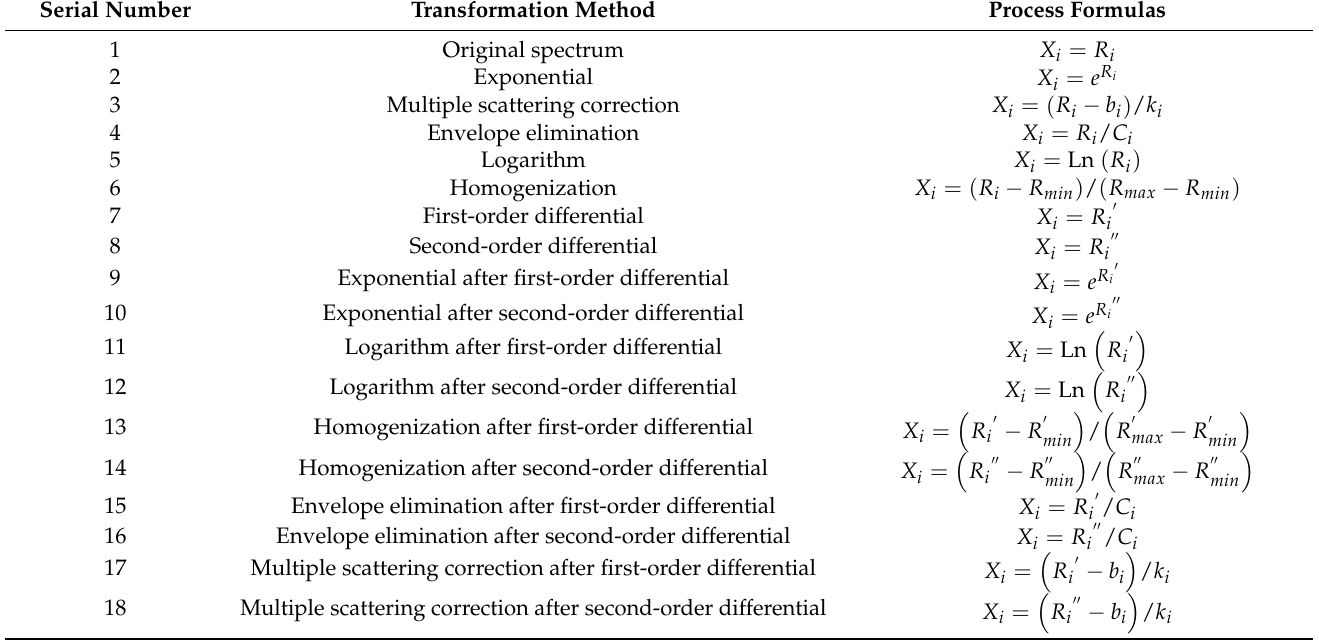
Table 2. Spectral transformation methods and calculation formulas. The collected spectral data are processed by a series of spectral transformations to highlight the effective information expression in the spectral